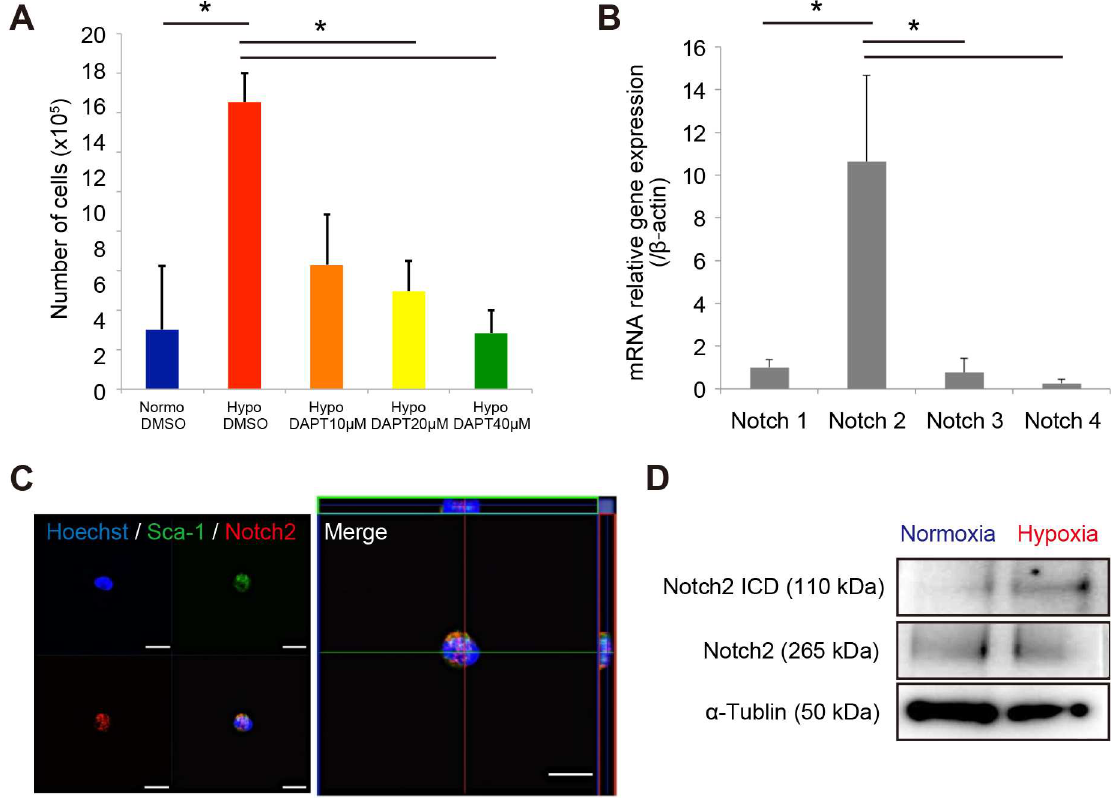
Fig 3. Notch signaling is upregulated in MSCs under hypoxic condition. (A) The effect of the Notch inhibitorDAPT on the MSC proliferation capacity. The normoxic group without DAPT treatment served as a control. (B) Quantitative real-time PCR of Notch family receptors (Notch1–4)in freshly sorted MSCs (P + S + cells) (n = 3). (C) Immunocytochemistry staining of Sca-1 (green), Notch2 (red), and DAPI (blue) in freshly sorted P + S + cells. (D) Western blotting of Notch2 ICD (ab52302,Abcam) and Notch2 full-length(D76A6, Sigma) expressionin cultured P + S + cells under hypoxicand normoxic conditions. α -tubulin(T9026, Cell signaling)served as a control. ICD,